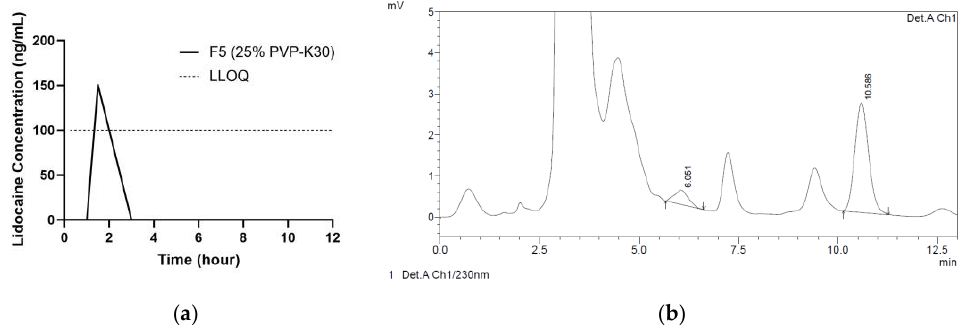
Figure 6. ( a ) The amount of LiH detected in one rat plasma at time point of 1.5 h from PVP group based on in vivo study. ( b ) Chromatogram of the plasma analysis following the application of F5 (LiH = 6.051 min).